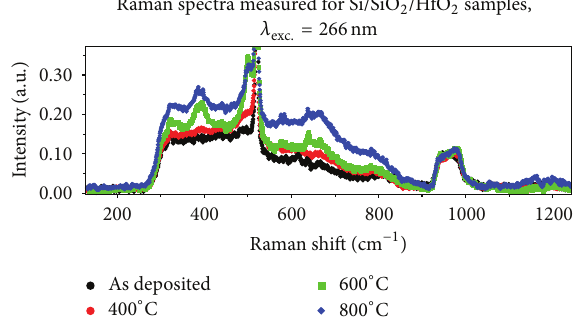
Figure 2: Raman spectra measured for Si/SiO 2 /HfO 2 sample, exci- tation wavelength 266 nm. Black solid line represents as-deposited sample, red points represents sample annealed at 400 ∘ C, green points represents sample annealed at 600 ∘ C, blue points represents sample annealed at 800 ∘ C.